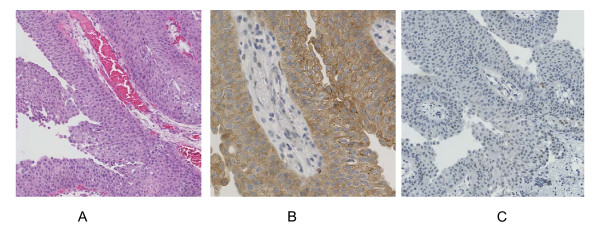
Protein expression levels of FGFR3 and TP53 in bladder tumor tissue. (A) Haematoxylin-Eosin staining of a papillary tumor. Original magnification ×20. (B) High levels of FGFR3 expression with a cytoplasmic and membranous patter. Original magnification ×40. (C) Low TP53 immunostaining of tumor cells showing a nuclear pattern. Original magnification ×20.